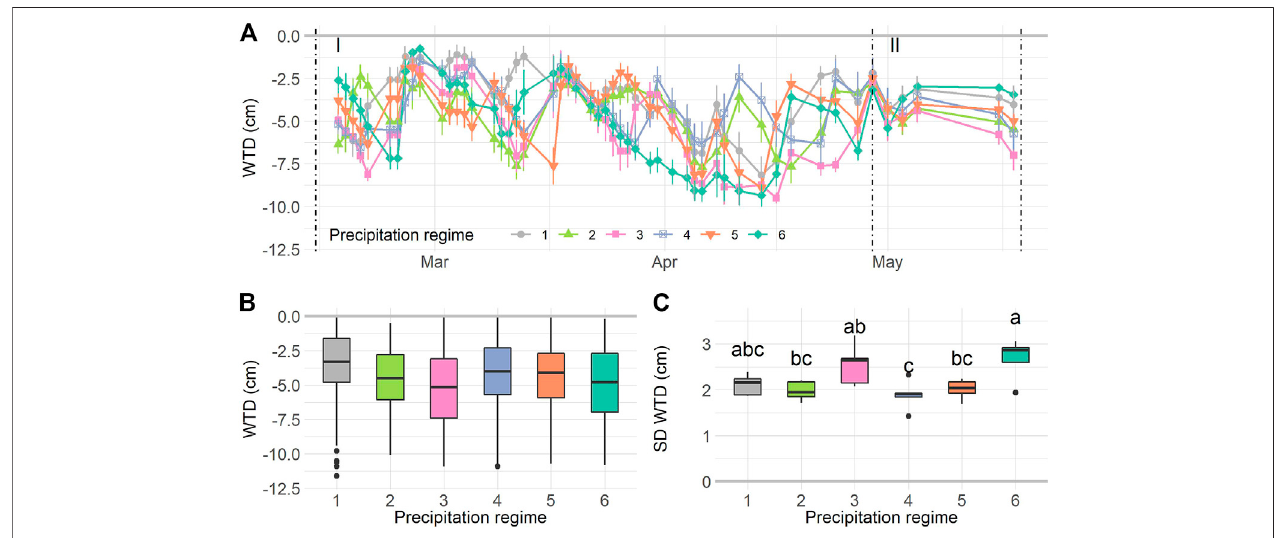
FIGURE2 | Water table depth(WTD) dynamics during theexperiment. WTD over time (A) during the resilience phase (I)and resistance phase (II).Forthe resilience phaseboxplotsaregivenformeanWTD (B) andstandarddeviationoftheWTD (C) perprecipitationregime.ValuesinAaremeans ± SE,n (cid:2) 1,560.InB:n (cid:2) 1,410,inC: n (cid:2) 30. Letters in C indicate signi fi cant differences ( p < 0.05) based on Tukey post-hoc test. For details on precipitation regimes, please see Figure 1